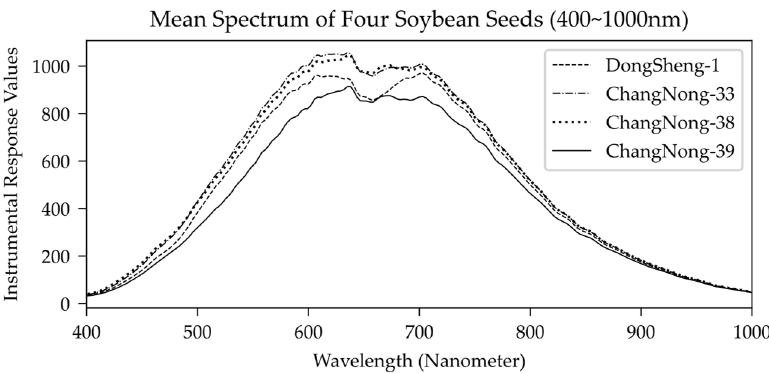
Figure 2. Mean spectral curves for four soybean categories.